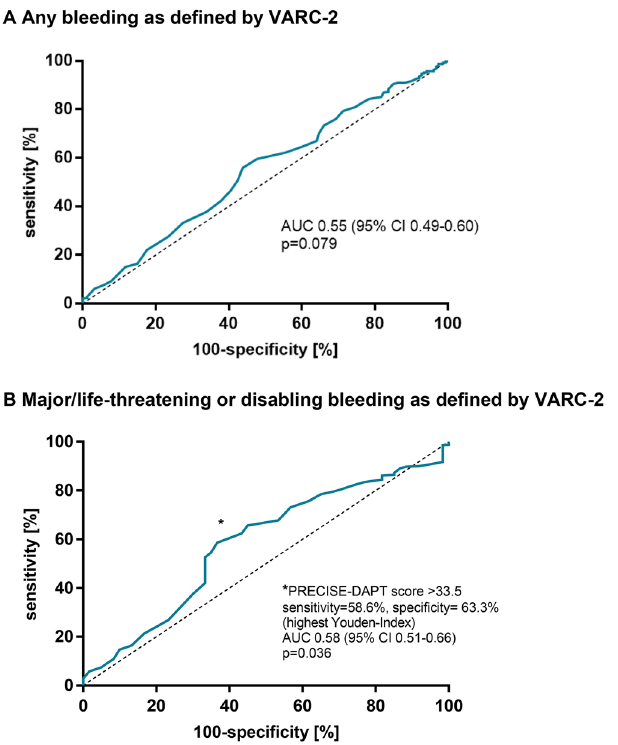
Figure 2. ROC curve analysis evaluating the diagnostic ability of the PRECISE-DAPT score within the DAPT group. (A) Based on receiver operating characteristic (ROC) curve analysis, the PRECISE-DAPT score was not significantly associated with the occurrence of any bleeding event. (B) In contrast, there was a significant, yet modest association with major/life-threatening or disabling bleeding